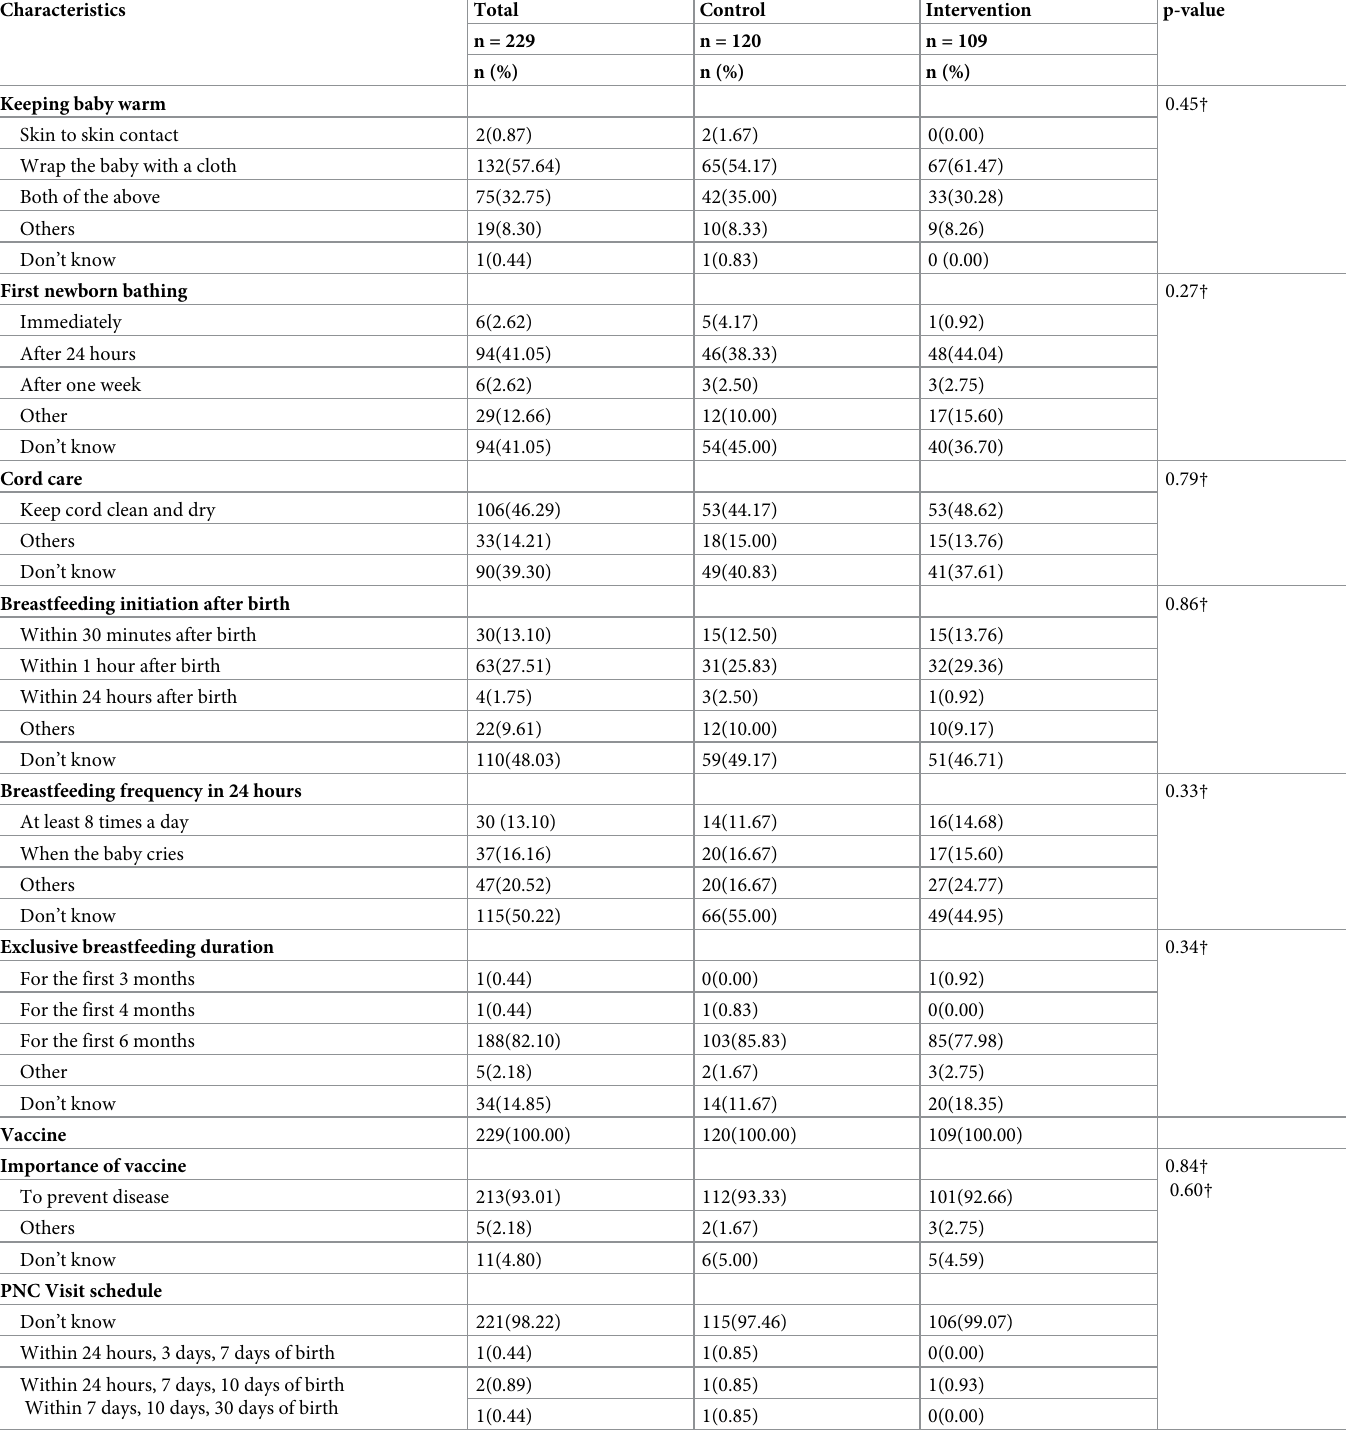
Table 8. Newborn care attributes knowledge of pregnant women between the intervention and control group at baseline, n = 229.